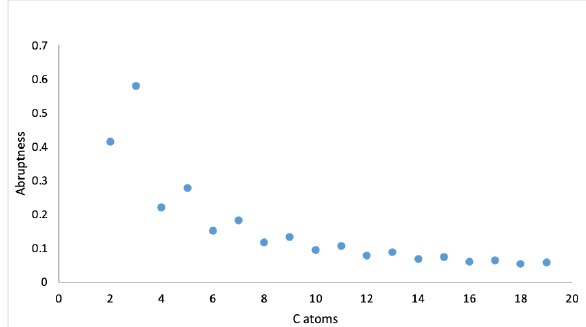
Figure 6. Distribution of abruptness of graph energy.